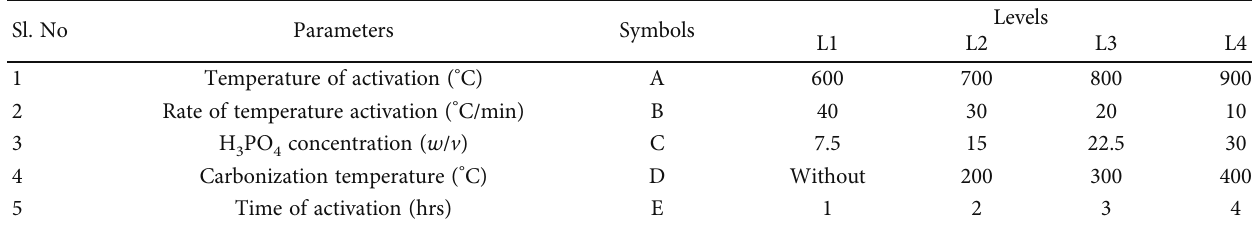
Table 1: Parameters and their